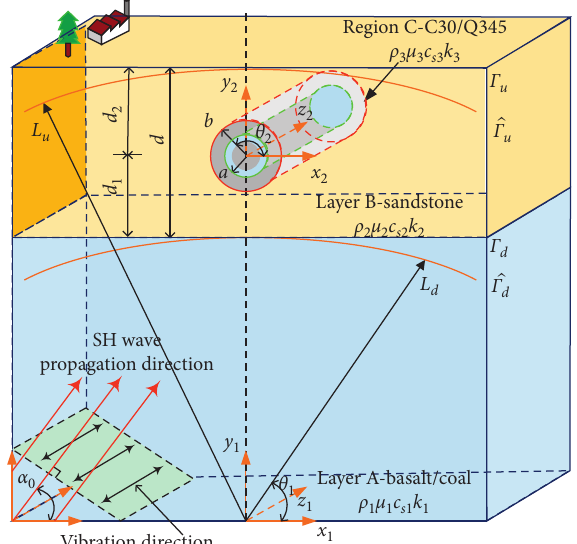
Figure 1: The composite strata